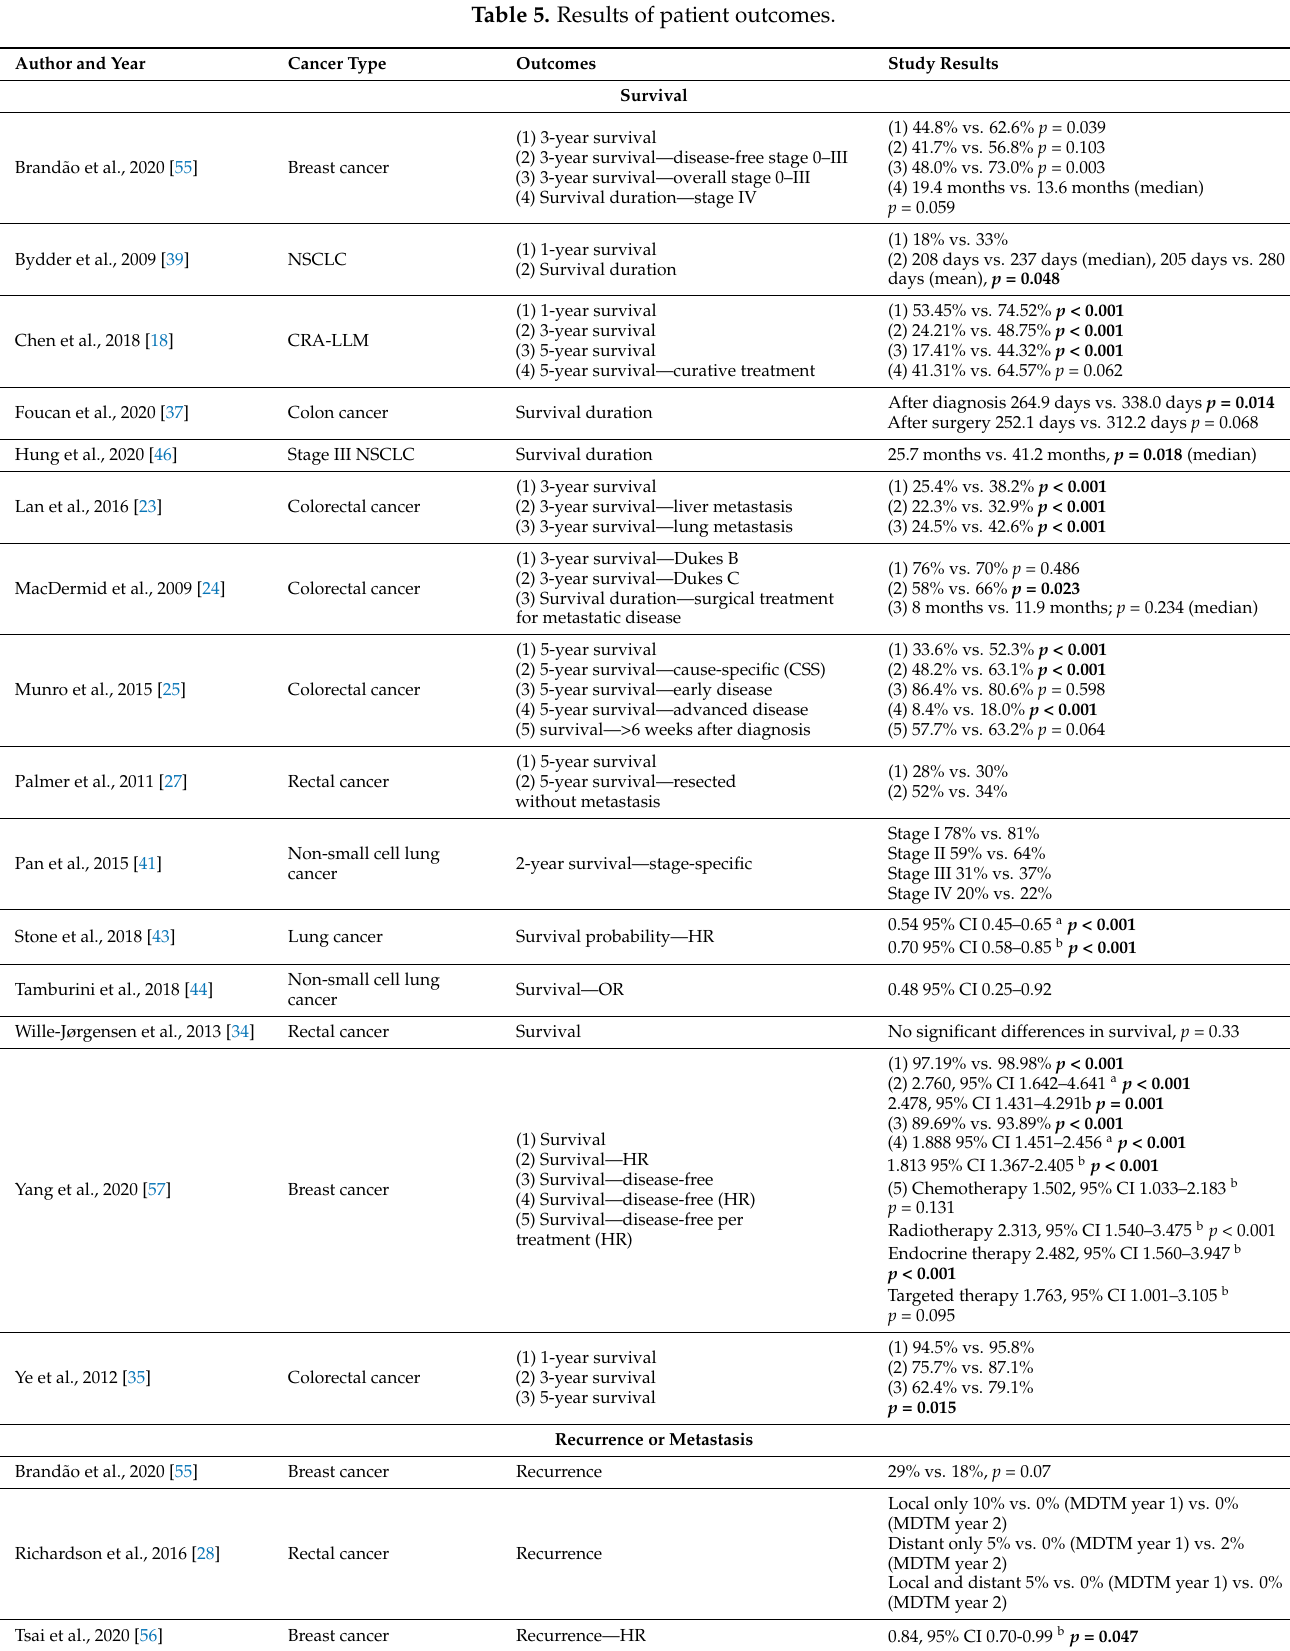
Table 5. Results of patient